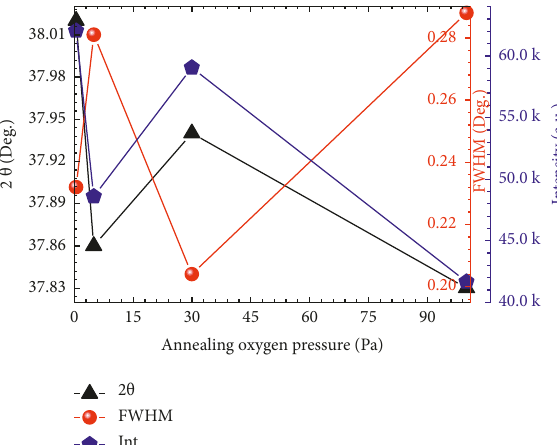
Figure 3: Calculated parameters depending on the peaks of XRD.